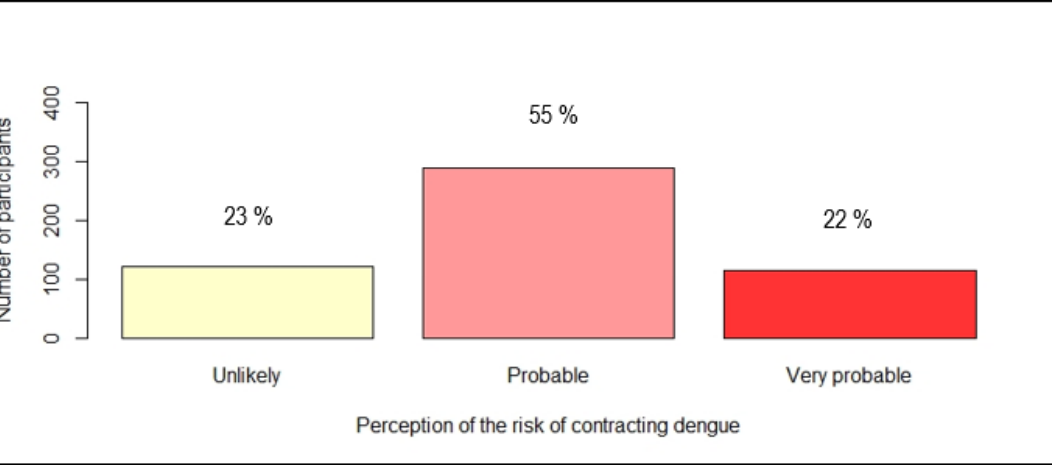
Table 2. Cross analysis between socio-demographic factors, previous experience of a dengue-like symptoms, level of knowledge about dengue, and perception of severity.